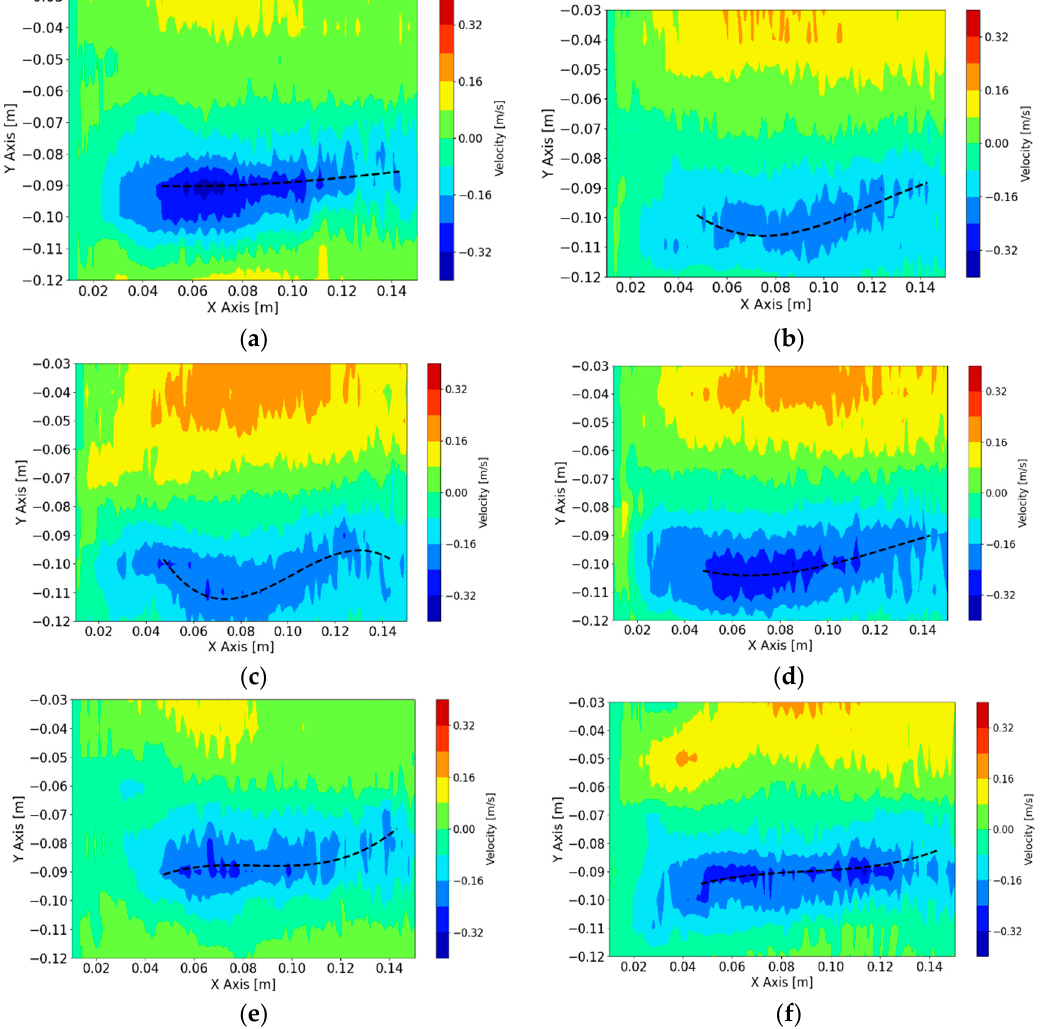
Figure 6. Reconstruction of velocity profile with tracking of jet shape to quantify jet velocity, ( a ) t = 200 s, ( b ) t = 400 s, ( c ) t = 500 s, ( d ) t = 600 s, ( e ) t = 800 s, ( f ) t = 1050 s.